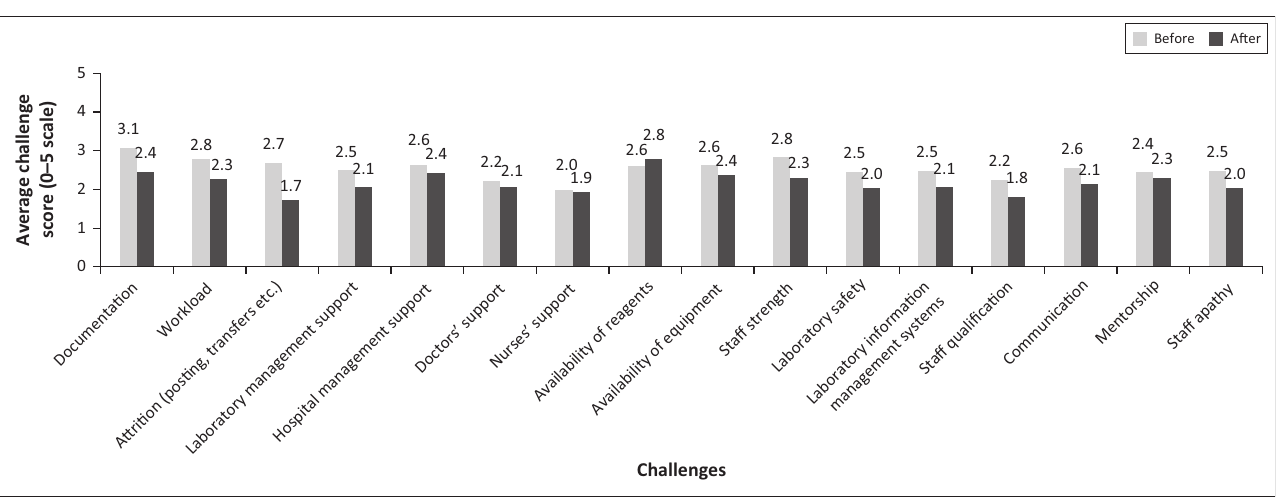
FIGURE 2: Comparison of the scores of key challenges to accreditation between personnel who joined the Pathology Division Laboratory, 37 Military Hospital, Accra, Ghana, before versus after accreditation, November 2020